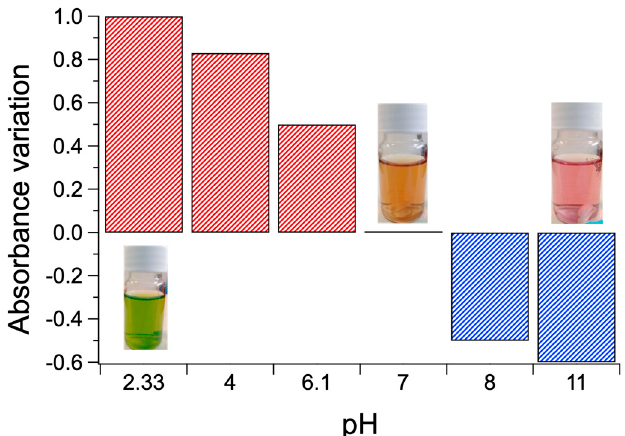
Figure 11. Positive (red) and negative (blue) absorbance variations from neutrality at 434 nm of the PKHEDA 1 × 10 ⁻ 4 M / TPPS 5 × 10 ⁻ 5 M colloids and corresponding color changes of the respective PKHEDA 1 × 10 − 4 M / TPPS 5 × 10 − 5 M colloids and corresponding color changes of the respective water solutions. water solutions.